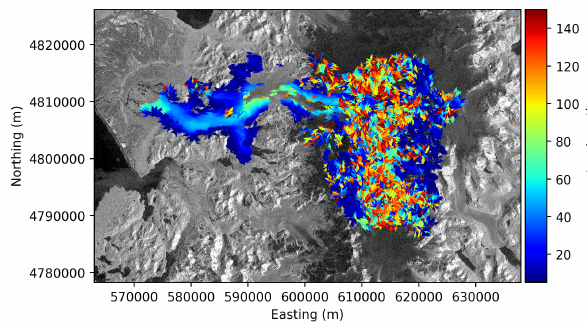
Figure 5. San Quintin Glacier surface velocity